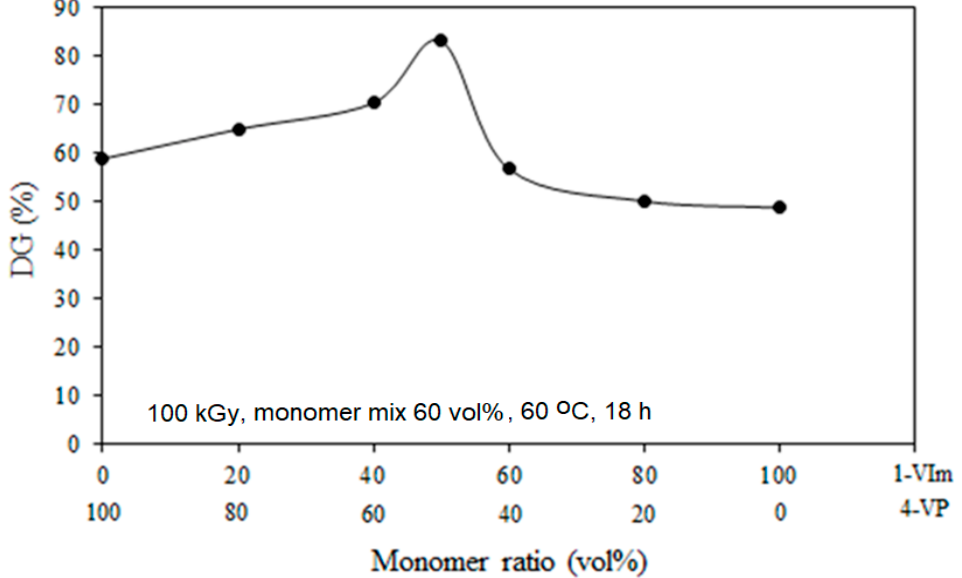
Figure 2. Variation of the degree of grafting with monomer ratio for grafting mixtures of 4-VP/1-VIm onto ETFE films.